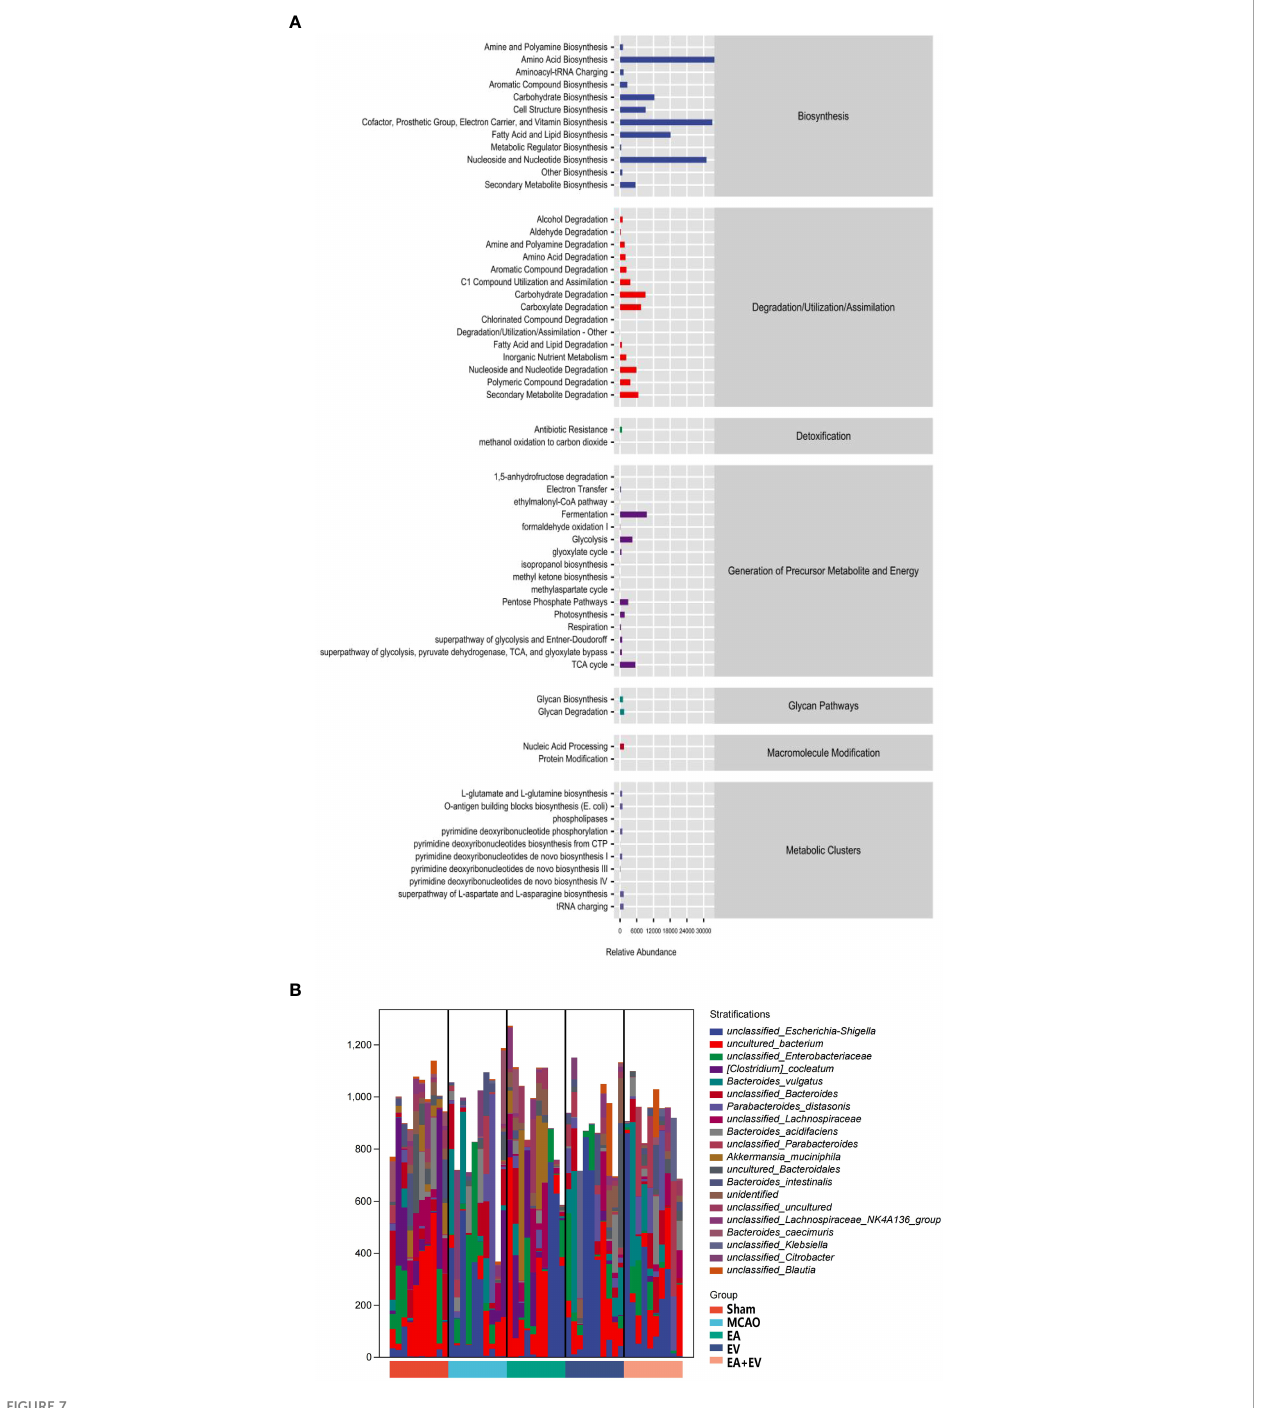
FIGURE 7 EA and iPSC-EVs treatments may regulate metabolic pathways after cerebral ischemia − reperfusion. (A) Metabolic pathway statistics. (B) Species composition of metabolic pathways,